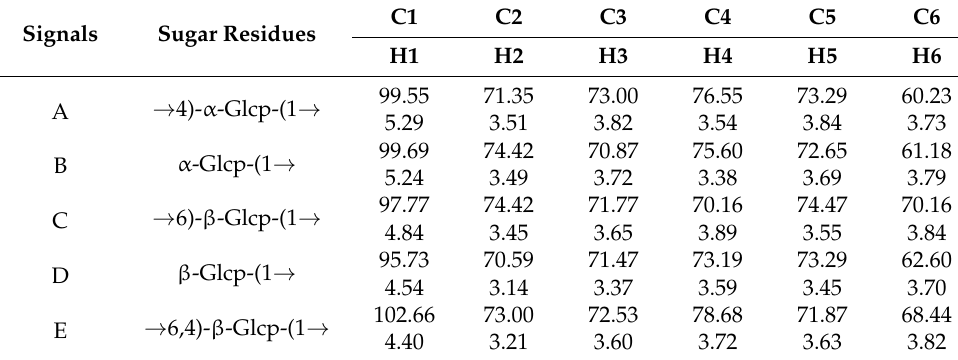
Table 2. Summary of 1 H and 13 C NMR chemical shifts of